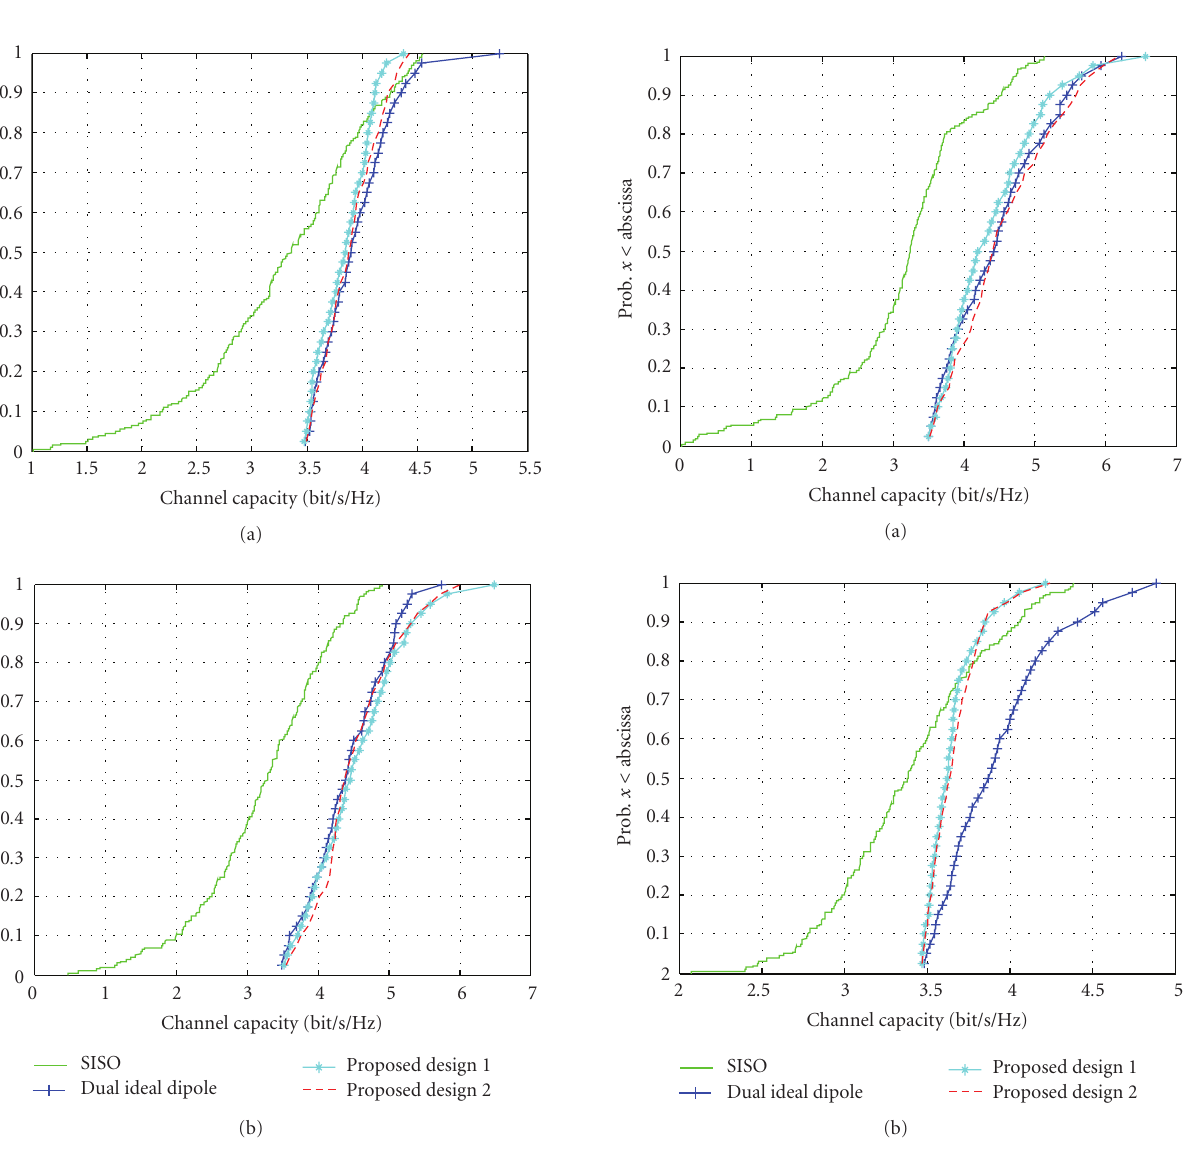
Figure 12: CDF for di ff erent receiver locations at Room B: (a) Rx3 and (b)